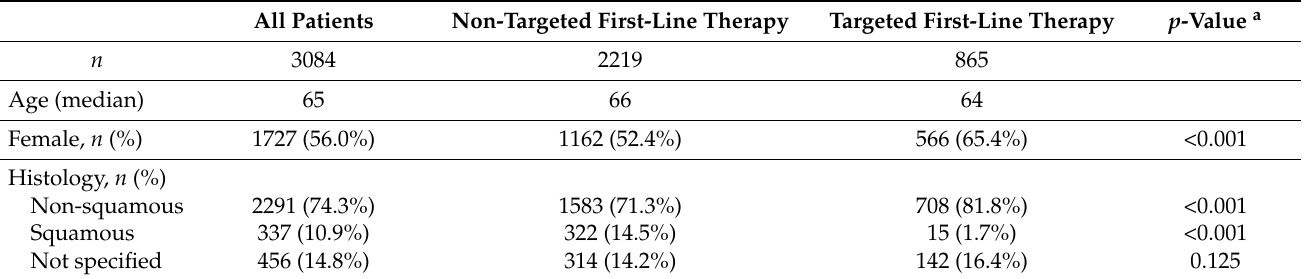
Table 1. Patient characteristics.